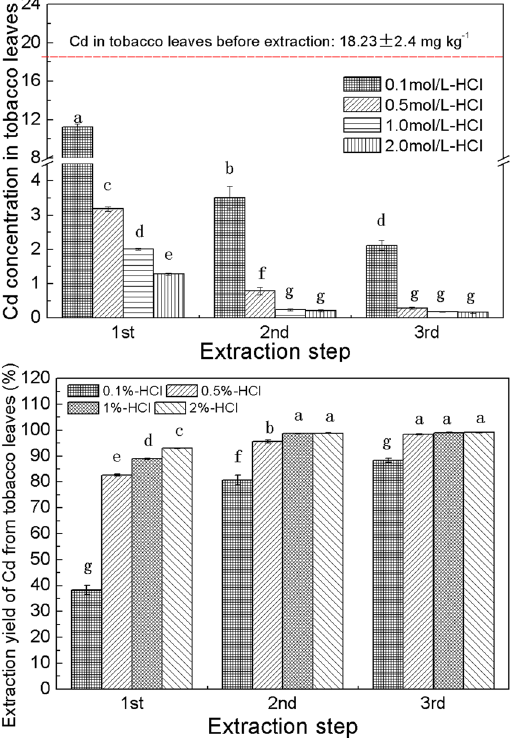
Figure 3. Cd concentrations in tobacco leaves and extraction yield (%) from tobacco leaves after the three step extraction using different concentration of HCl. Bar plots with SE of means, while different letters indicate significant variations between different HCl concentrations and extraction steps on the basis of Duncan’s multiple range test ( P ≤ 0.05).